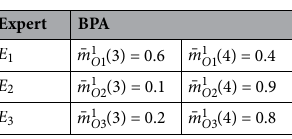
Table 3. The negation of BPAs.